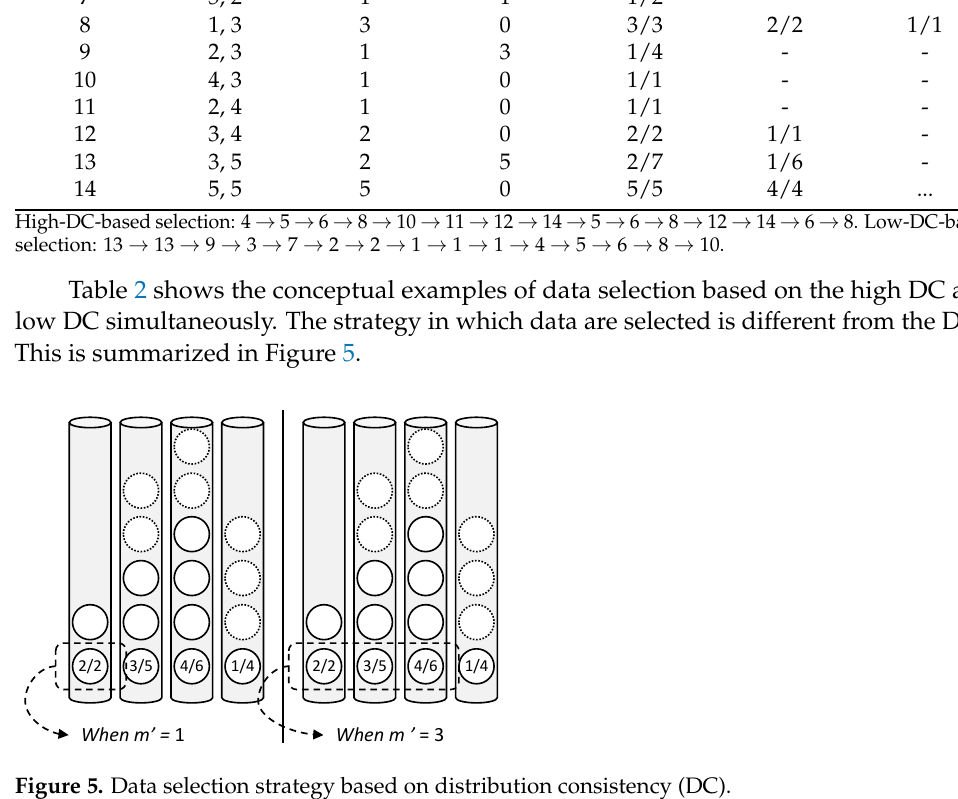
Figure 5. Data selection strategy based on distribution consistency (DC).